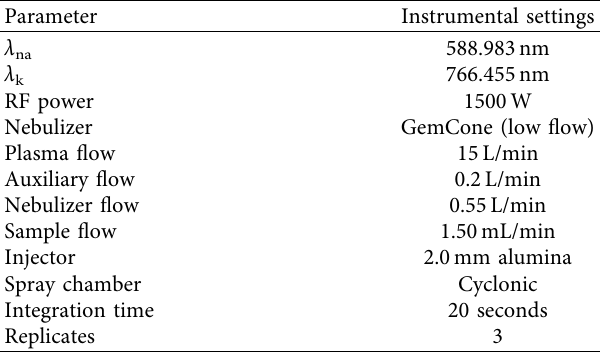
Table 1: ICP-OES parameters for the analysis of K + and Na + for the various soil